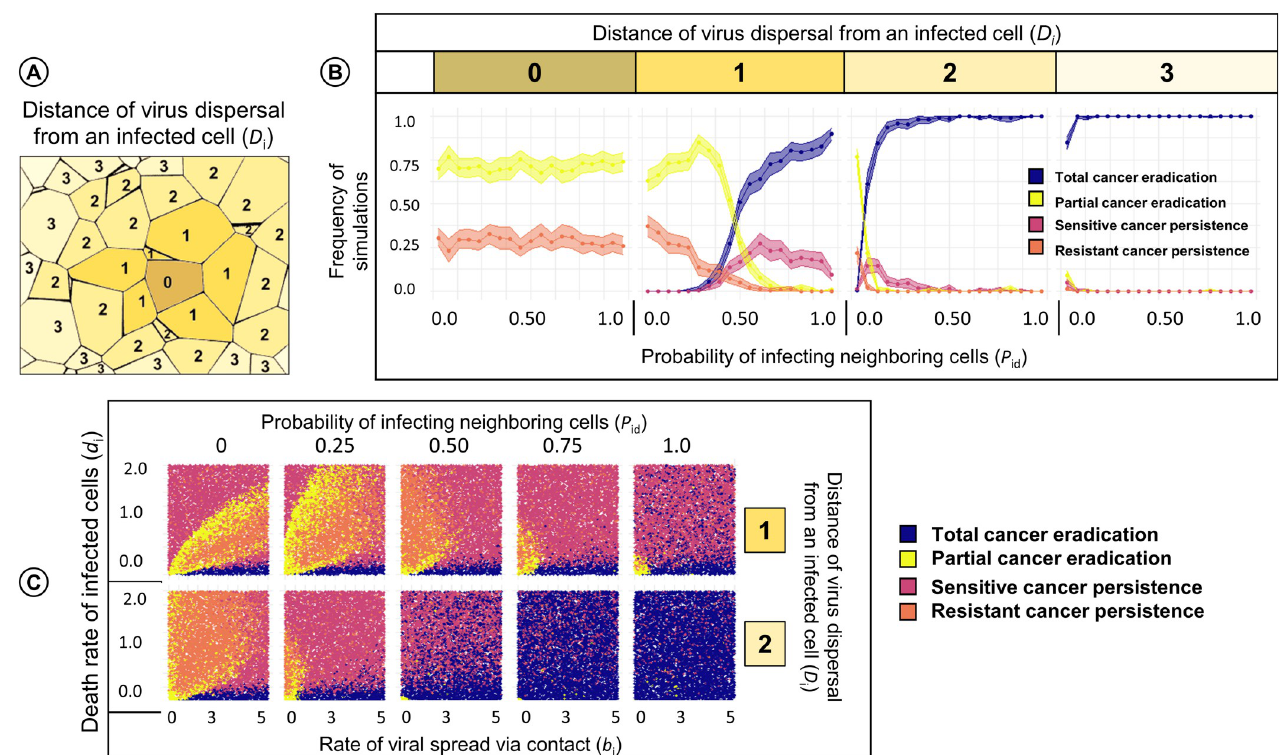
Fig 6. Effect of viral dispersal distance and the probability that neighbouring cells are infected via diffusing viruses on the therapeutic outcome. In the Voronoi model, we considered various dispersal distances of the virus. For each dispersal distance, we changed the probability P id that upon the death of an infected cell the cells in the diffusion neighbourhood of that cell are infected, keeping all other parameters at their default values. (A) Interpretation of the viral dispersal distance, here ranging from 0 to 3. A focal cell marked “0” has distance zero to itself, distance one to its neighbours, distance two to its neighbours, etc. (B) Therapeutic outcome for dispersal distances 0, 1, 2, and 3 in relation to the probability P id of being infected by an infected neighbour. For each graph, 10,000 simulations were run; coloured lines and envelopes indicate the bootstrapped mean simulation outcome and the 95% confidence band. In (C) we changed the P id and dispersal distance for the same range of parameter values as in Fig 3 (rate of viral spread and death rate of infected cells) and 10,000 simulations were run for each graph. Each simulation outcome is represented by a point, the colour of which indicates the therapeutic outcome.